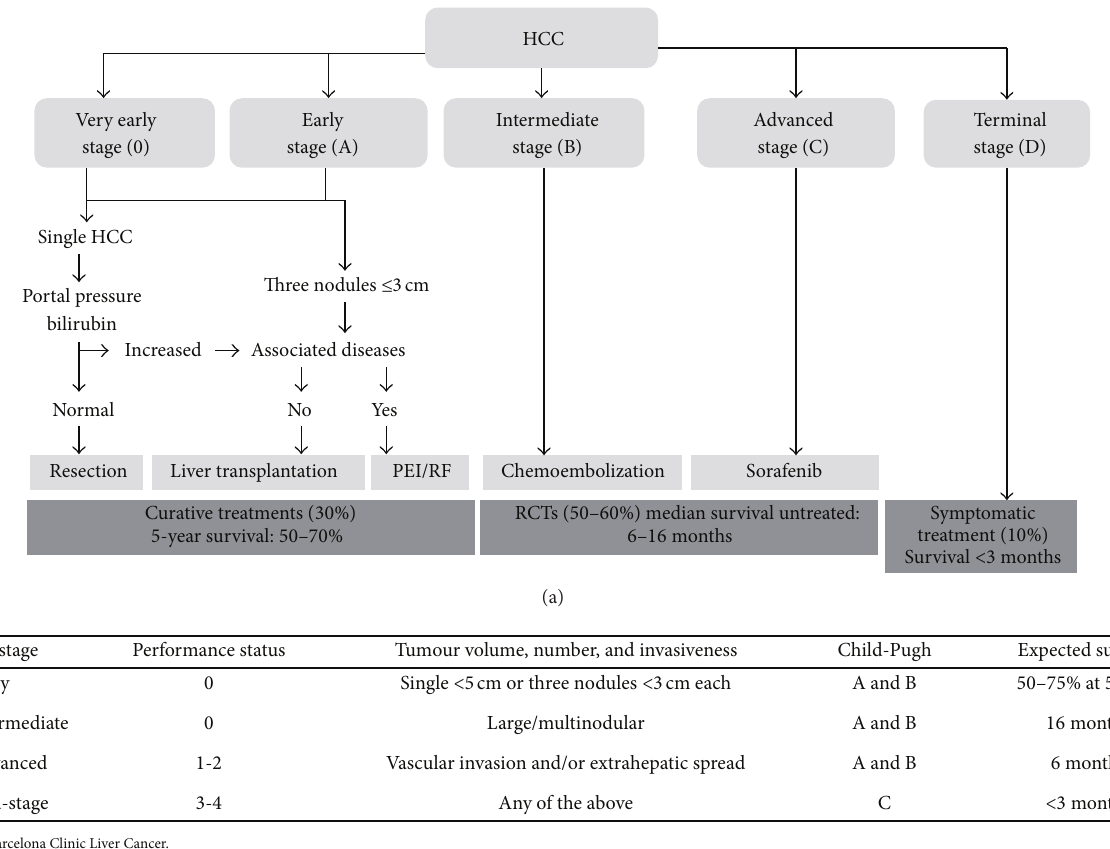
Figure 1: ((a), (b)) Strategy for staging and treatment assignment in patients diagnosed with HCC according to the BCLC proposal [12].